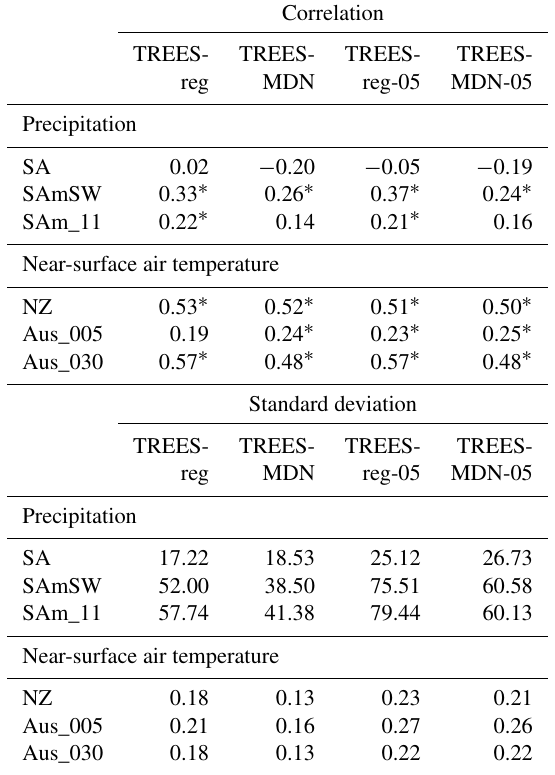
Table 5. Pearson correlation coefficient between the reconstructed and GMF near-surface air temperature and precipitation over 1901– 2000CE for different DA experiments (Table 1, with tree-ring prox- ies only, with the full observation error or half of the observation error; see Sect. 3 for more details) in different regions (Sect. 3) and proxy sites (Fig. 1). Standard deviation of the reconstruction in degrees Celsius ( ◦ C) (near-surface air temperature) or in mil- limeters per year (mmyr − 1 ) (precipitation). SA stands for South America, SAmSW for the southwestern border of South America in the Andes where the TRW proxy sites are located and NZ for New Zealand. Aus refers to a site in New Zealand and SAm in South America. Asterisks stand for significant correlation coefficients at the 95% confidence level. Correlation TREES- TREES- TREES- TREES- MDN